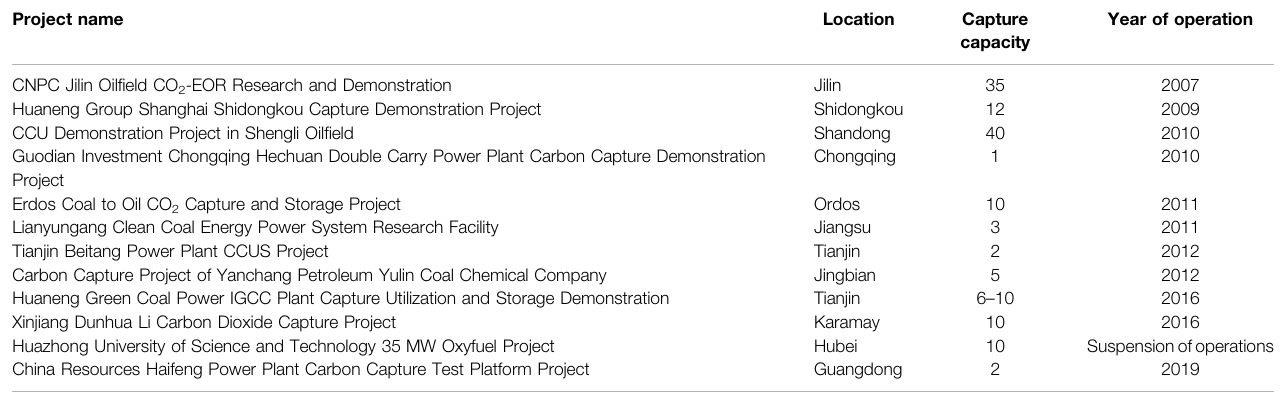
TABLE 1 | Completed CCUS demonstration projects in China (Duan et al., 2018).